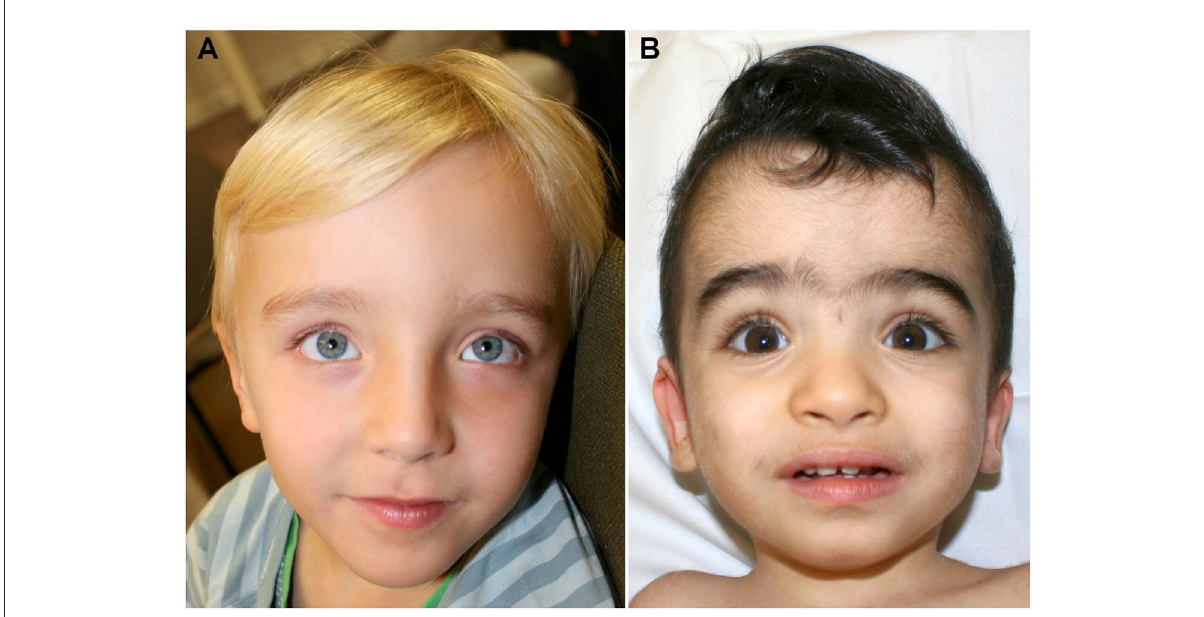
FIGURE1 (A) Facial aspect of patient 1 at the age of 6 years showing prominent forehead and hypertelorism. (B) Face of patient 2 at the age of 18 months. Prominent forehead, synophris, hypertelorism and mildly downward slanting palpebral